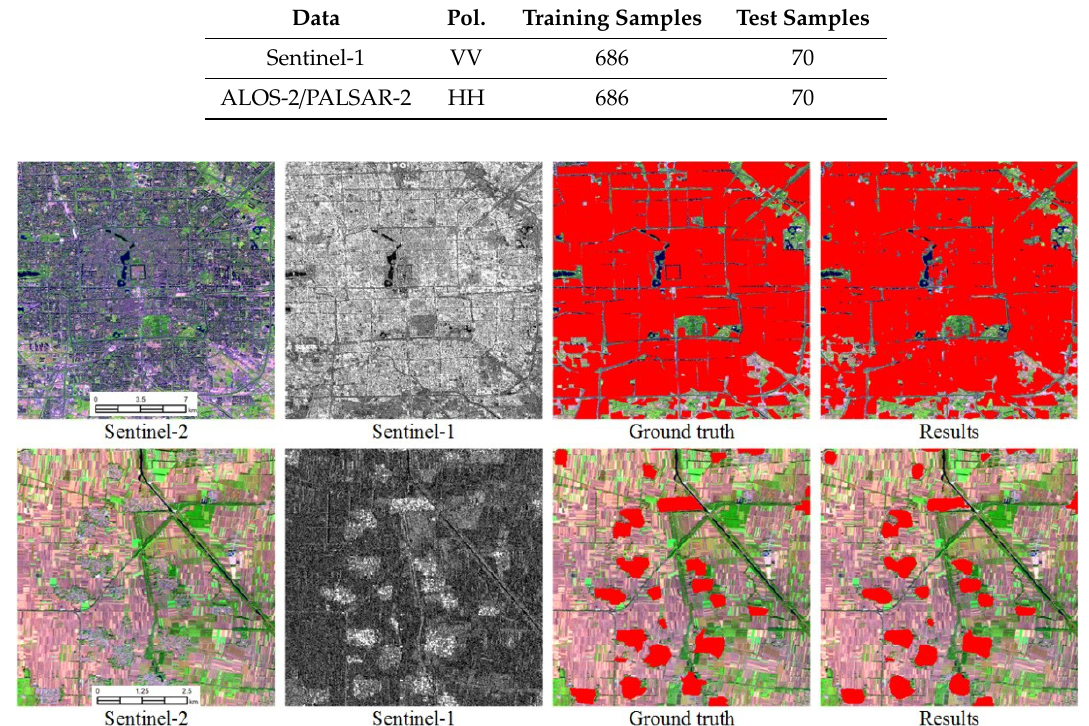
Figure 13. Building area extraction results based on the proposed method using Sentinel-1 data.